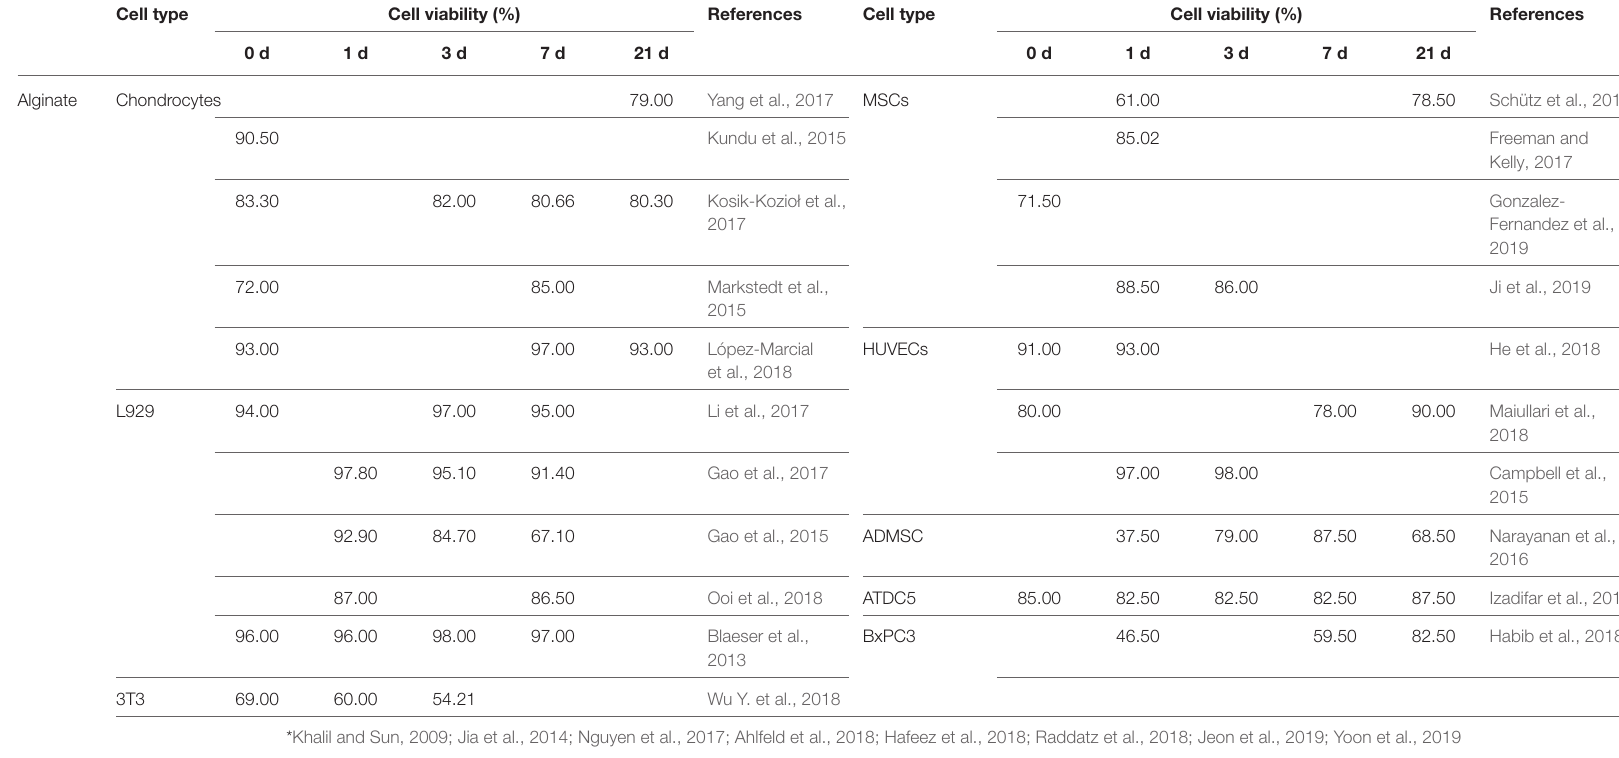
TABLE 5 | Cell type with its viability grouped according to materials used in five categories (from 0 to 21 days) and expressed in percentage of cells survival. Cell type Cell viability